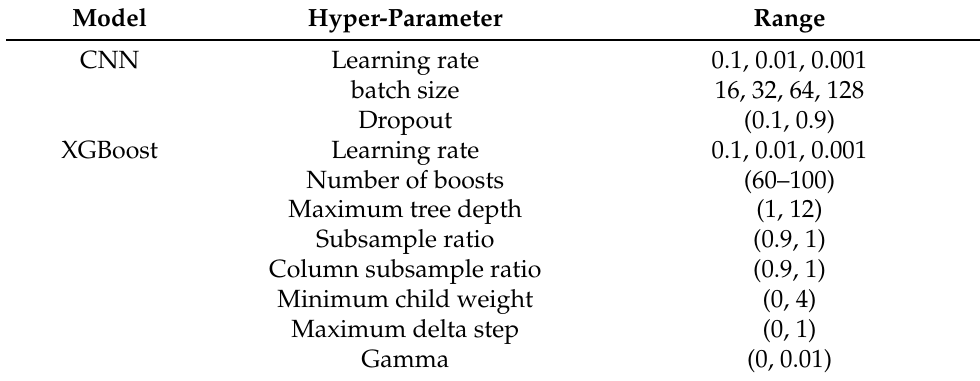
Table 3. Search space set of CNN and XGBoost by